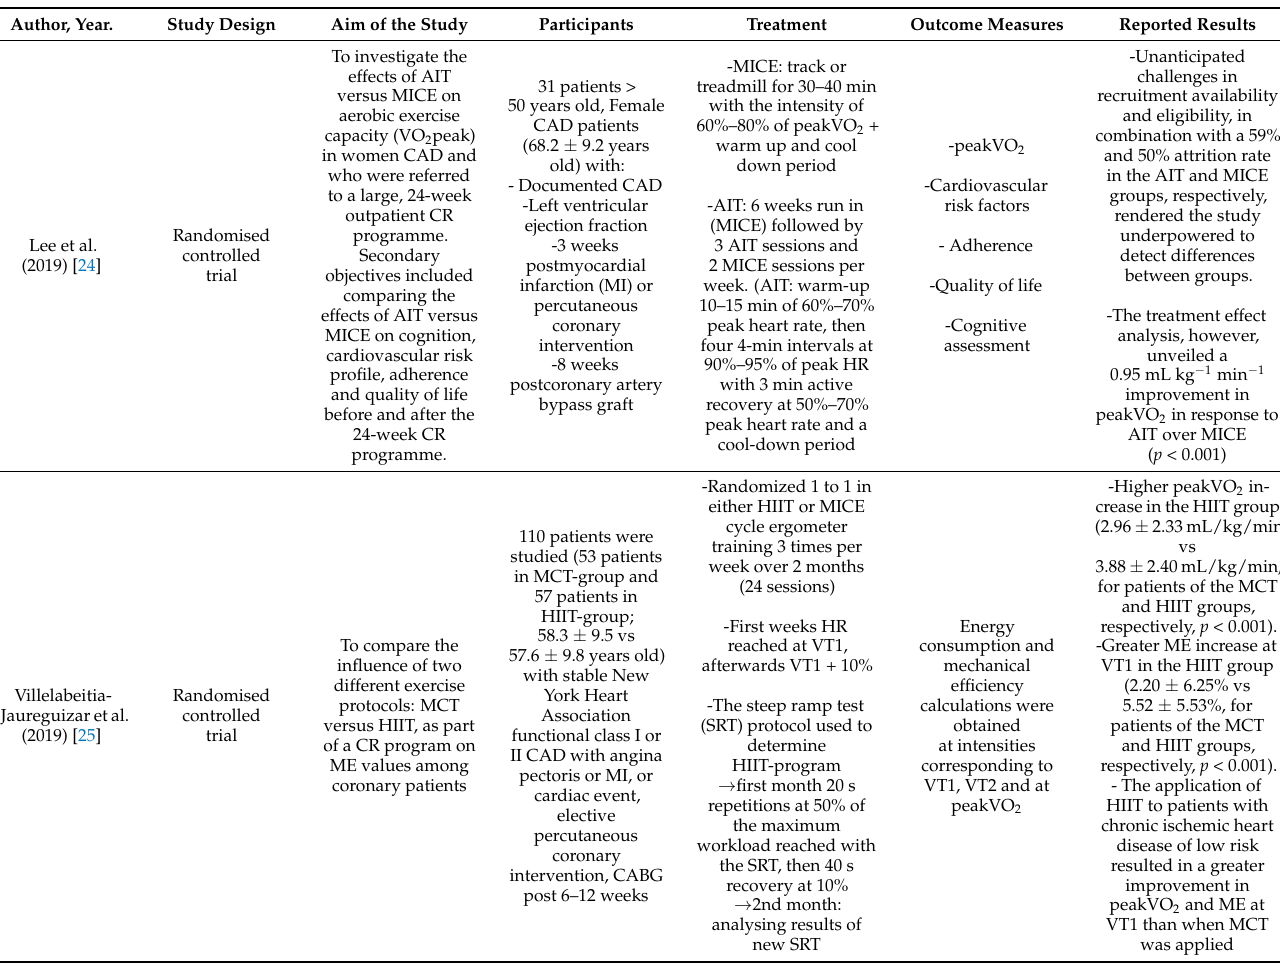
Table 1. The effects of HIIT versus MICT on aerobic fitness and quality of life (QoL) in patients suffering from CABG (description of included